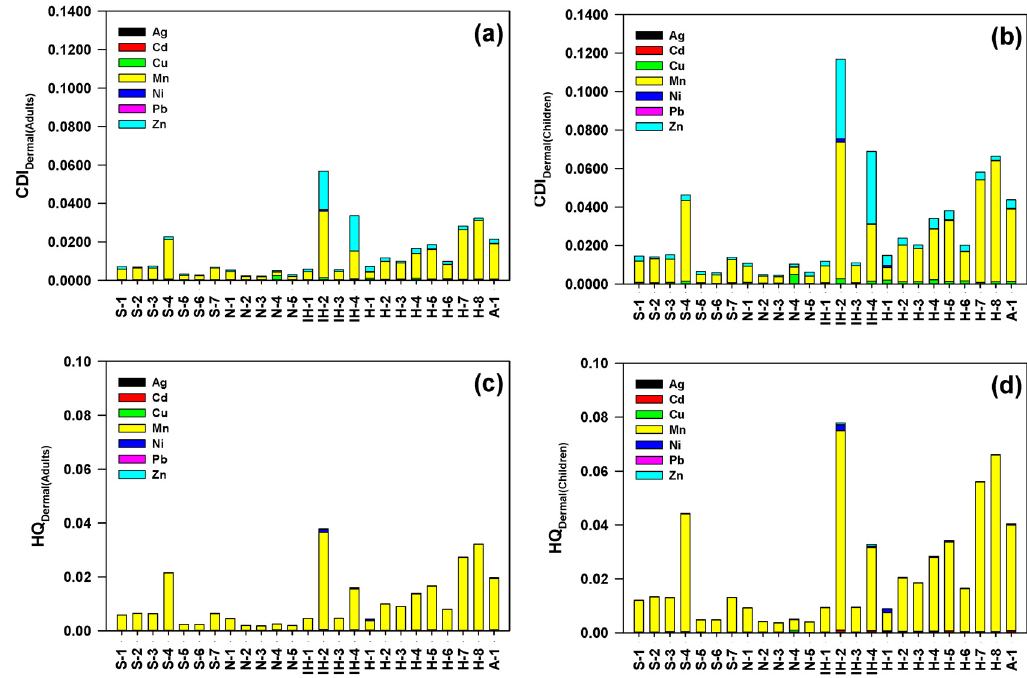
Figure 8. Variation of chronic daily intake (CDI) and hazard quotient (HQ) values for dermal absorption rate in ( a , c ) adult and ( b , d ) children population groups in the Han River